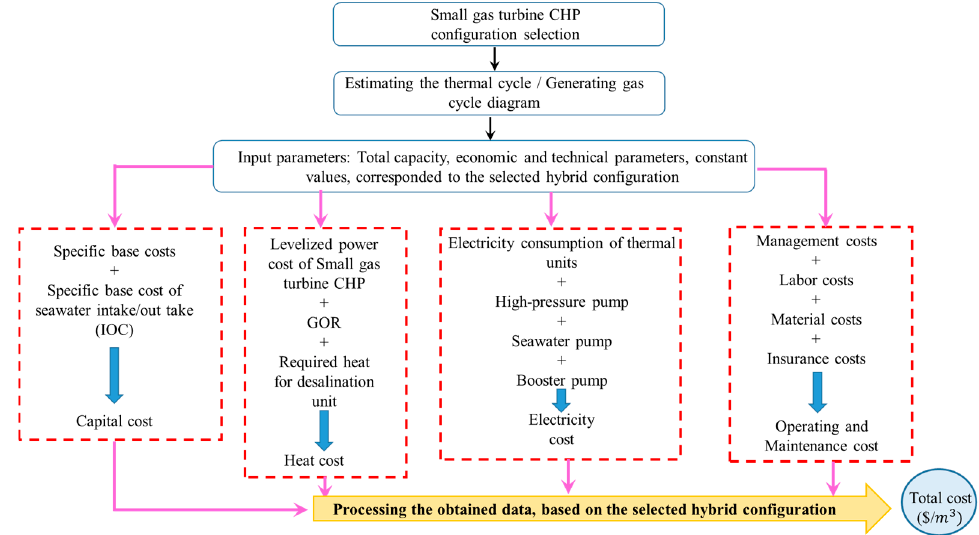
Figure 3. The techno-economic evaluation flowchart based on the DEEP program.